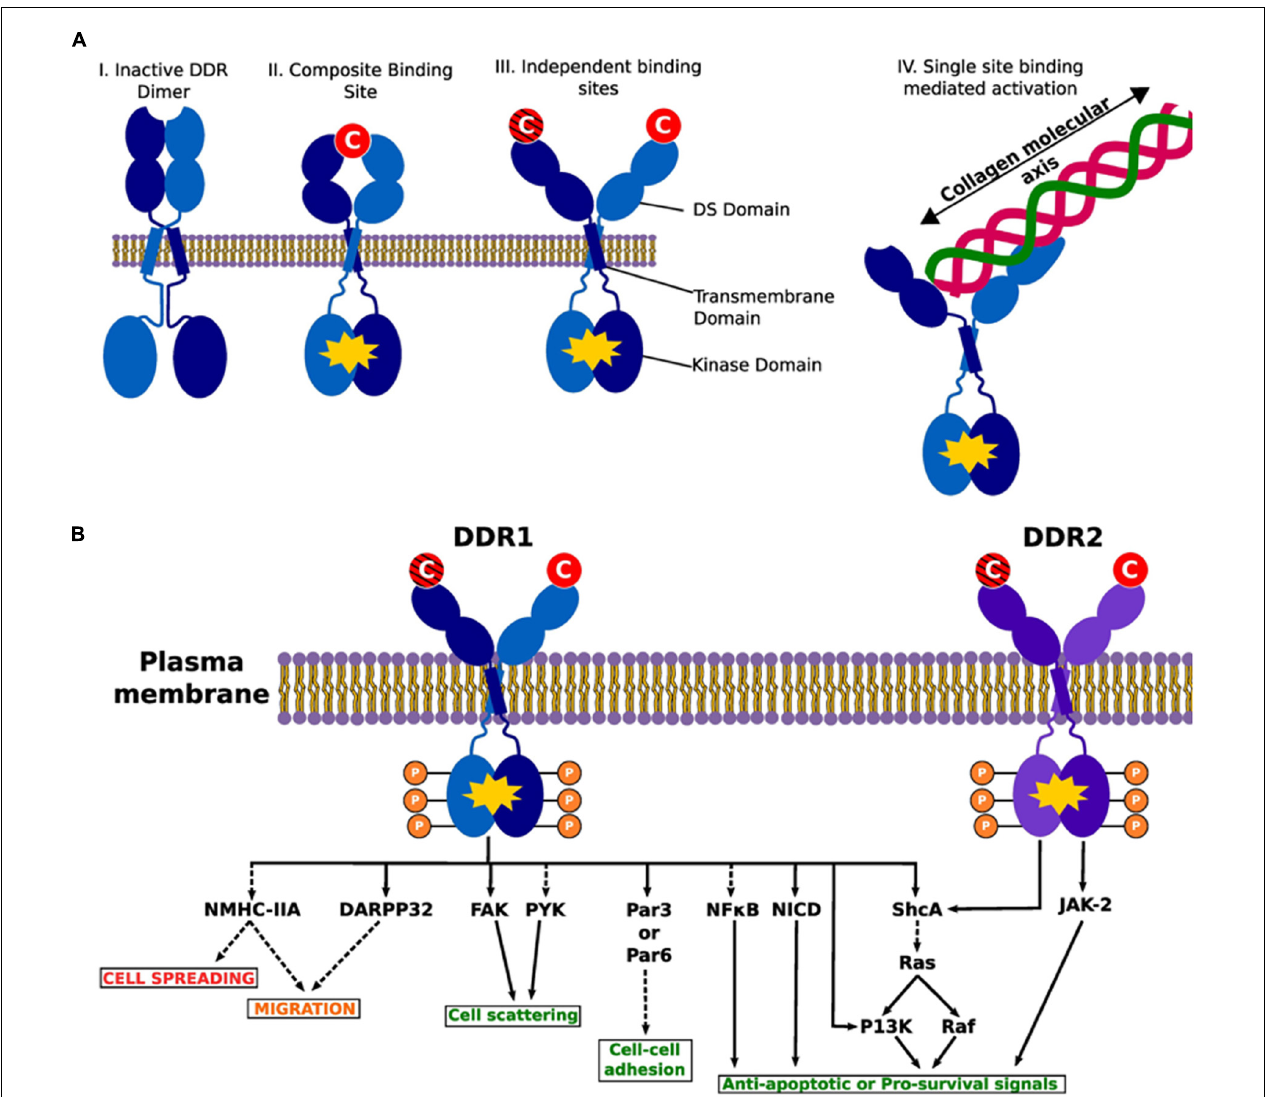
FIGURE 5 | Illustration of DDR activation by fibrillar collagens. Activated dimers are depicted with a yellow polygon on the intracellular kinase part of the dimer. (A) The various possible conformations of the DDR1 dimer in active and inactive states. DDRs are activated upon binding with fibrillar collagens in the DS domain. (I) An inactive DDR dimer. (II) Activated DDR dimer by composite binding. Here the collagen binding sites from each monomer create a “composite” binding site to bind to collagen to activate the intracellular kinase. (III) Individual binding sites on each monomer may interact with different collagen monomers leading to activation. The crosshatched collagen monomer illustrates that binding to both domains at the same time may or may not be necessary for activation (i.e., it is possible that binding of a single collagen molecule to a single DS domain activates the entire complex). (IV) As alluded to in III, a single collagen molecule binds just one DS domain. Illustrates the collagen molecular and DDR interaction. We present previous evidence of a collagen engagement on the binding site of a monomer leads to DDR activation. II–IV represent possible means of activation. (B) A list of common intracellular targets and cellular cascades that result from DDR activation. Phosphates are shown to demonstrate the kinase activity of the DDRs. The red text shows processes that are suppressed by DDR signaling, green text represents processes that are promoted and the orange text represents processes that are either suppressed or promoted. Dashed lines indicate indirect activity and solid lines show direct interaction and effects. DARPP-32, dopamine- and cAMP-regulated phosphoprotein, Mr 32 kDa; FAK, focal adhesion kinase; JAK-2, janus kinase 2; NF- κ B, nuclear factor kappa B; NICD, notch 1 intracellular domain; NMHC-II, non-muscle myosin IIA heavy chain; P13K phosphatidylinositol 3-kinase; Par3/Par6, cell polarity regulators; PYK, protein tyrosine kinsase; ShcA, SH2 containing transforming protein A. Reprinted from Orgel and Madhurapantula